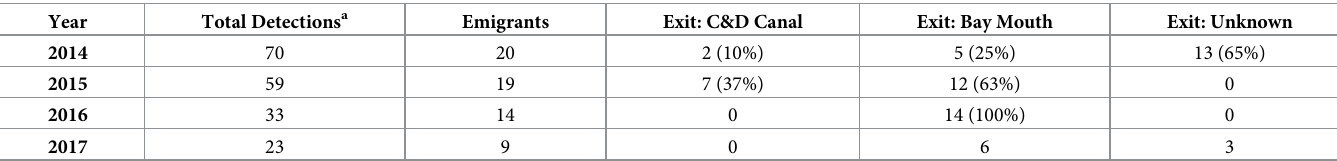
We observed spawning site fidelity (annual spring return to the Potomac River) in the majority of large individuals (Table 3), with straying only observed to occur in other Chesapeake Bay Table 2. Numbers and percentages of estimated emigrants according to exit routes from the Chesapeake Bay. Year Total Detections